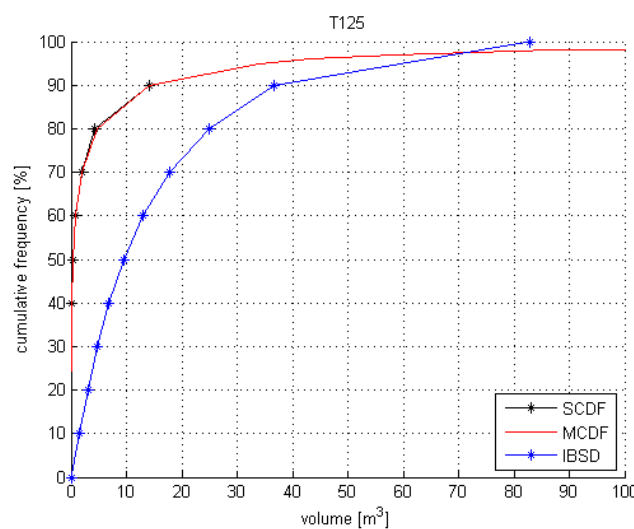
Figure 13. Comparison of block volume distributions obtained for term T125.